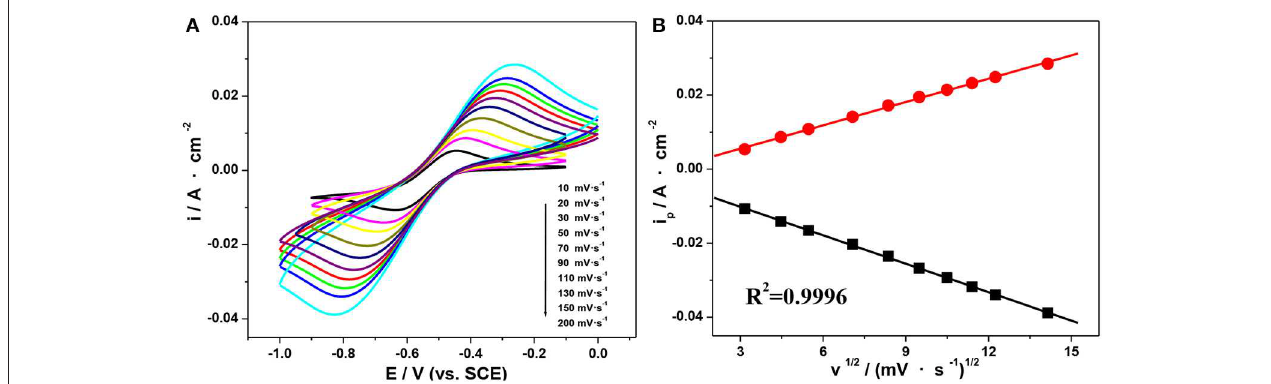
FIGURE 7 | CV curves of an SPGR in 0.5 mol · L − 1 V(III) with 2.0 mol · L − 1 H 2 SO 4 electrolyte at 283.15K (A) , 293.15K (B) , 303.15K (C) , and 313.15K (D) .